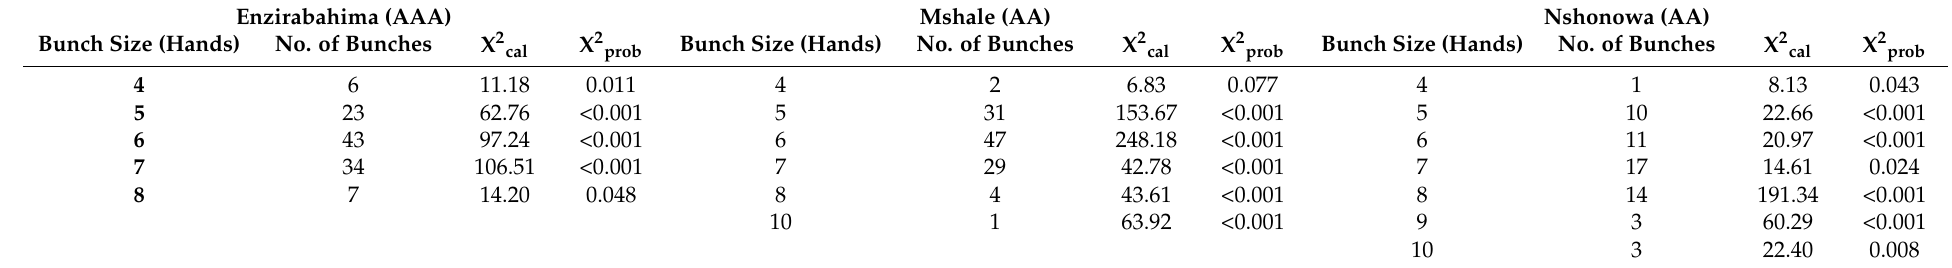
Table A4. Chi-square test of goodness of fit for seed set per hand of different size bunches of “Enzirabahima”, “Mshale” and “Nshonowa” pollinated with “Calcutta 4”, between